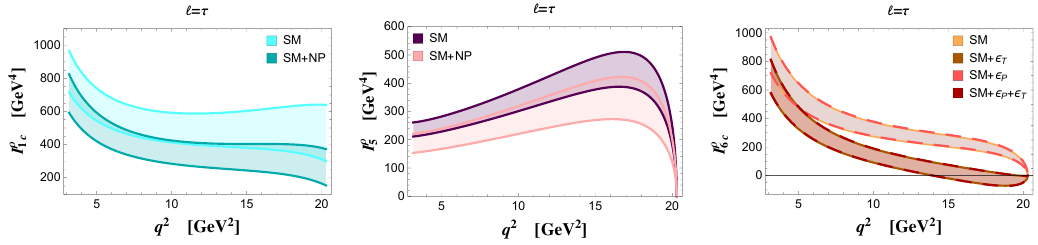
( q 2 ) ( left ), I ρ ( q 2 ) ( middle ), I ρ 5 1 c